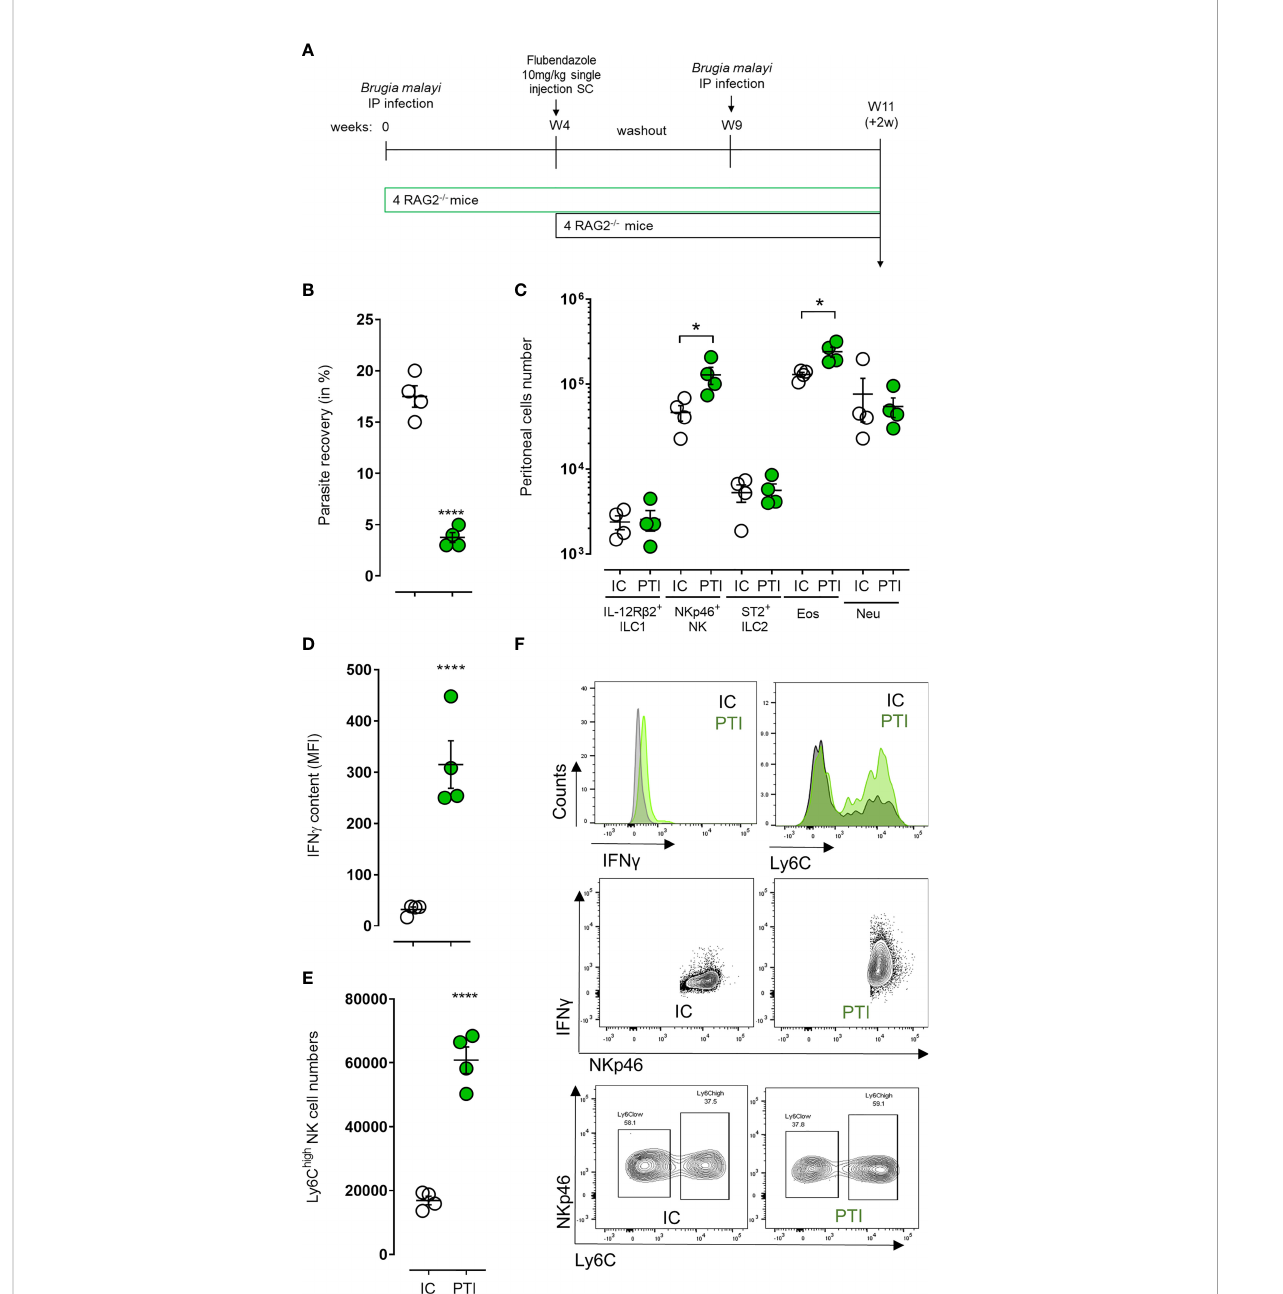
FIGURE 4 NKp46 + NK cells display signs of enhanced/memory-like activation and boost anti- fi larial immune response in challenge after immune-priming. (A) Schematic representation of the study design where B. malayi infected RAG2 -/- mice were treated with fl ubendazole at 10mg/kg 4 weeks post-infection to clear them out of remaining worms before being challenged again at week 9 with B. malayi parasites and a readout 2 weeks post-challenge. (B) Parasite recovery in infected control mice (IC, clear) or primed treated infected (PTI, green) mice 2 weeks post-challenge. (C) Innate lymphoid cells (IL-12R b 2 + ILC1, NKp46 + NK, ST2 + ILC2) and granulocytes (eosinophils – Eos and neutrophils – Neu) numbers in the peritoneal cavity of infected control (IC, clear) or primed treated infected (PTI, green) mice at 2 weeks post-challenge. (D) IFN g content expressed as MFI in peritoneal NKp46 + NK cells from IC (clear) or PTI (green) mice 2 weeks post-challenge. (E) Ly6C high NKp46 + NK cell numbers in the peritoneal cavity of IC (clear) or PTI (green) mice at readout. (F) Representative histograms and fl ow plots for IFN and